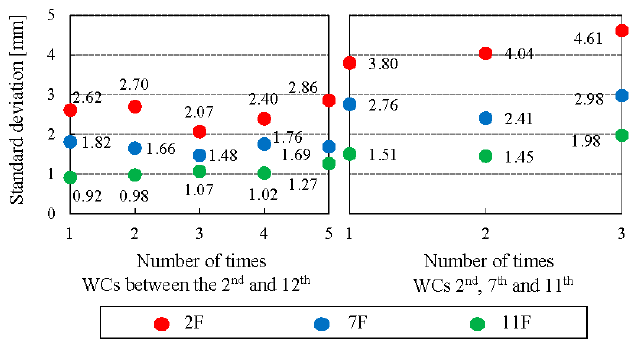
Figure 4. Illustration of the SDs of seal water fluctuation (4.0 Figure 4 . Illustration of the SDs of seal water fluctuation (4.0 L/s). Figure 4 . Illustration of the SDs of seal water fluctuation (4.0 L/s).